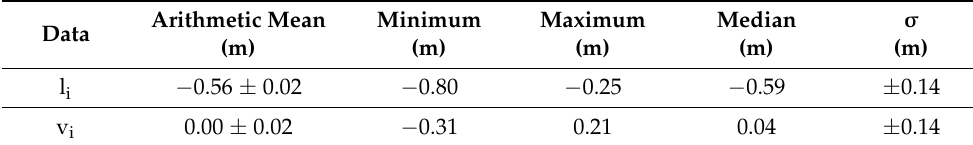
Table 2. Statistical analysis of the dataset for differences (l i ) and corrections (v i